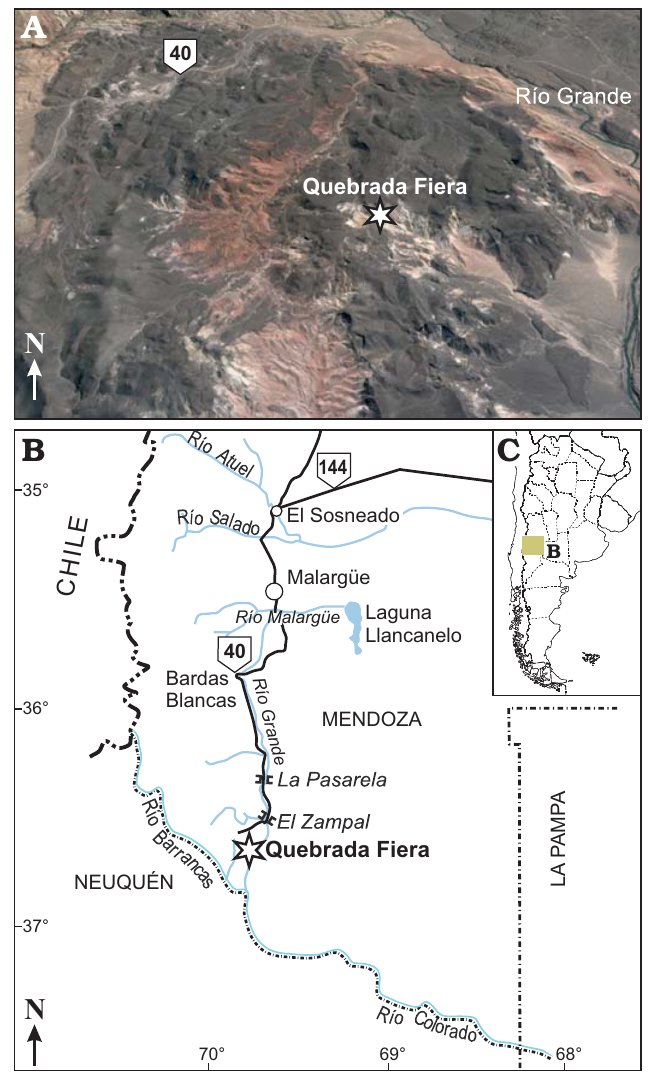
Fig. 1. Google Earth view of Quebrada Fiera site ( A ). Location of the study area on the map of Argentina ( C ). Geographical location (asterisk) of the fossil locality ( B ).{fig. will be grayscale in printed